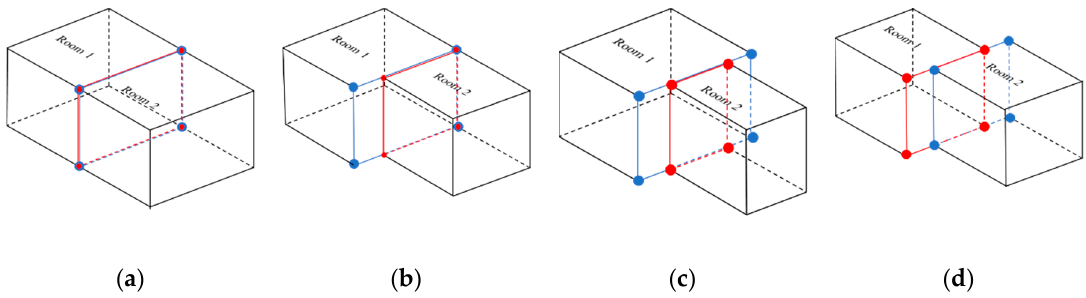
Figure 5. Issues of adjacent rooms: ( a ) both rooms are equal; ( b ) One bigger than the other but with a common vertical side; ( c ) One is bigger than the other; ( d ) One room is displaced from the other. Spaces are assigned numbers 1 and 2 in order of detection during the process.